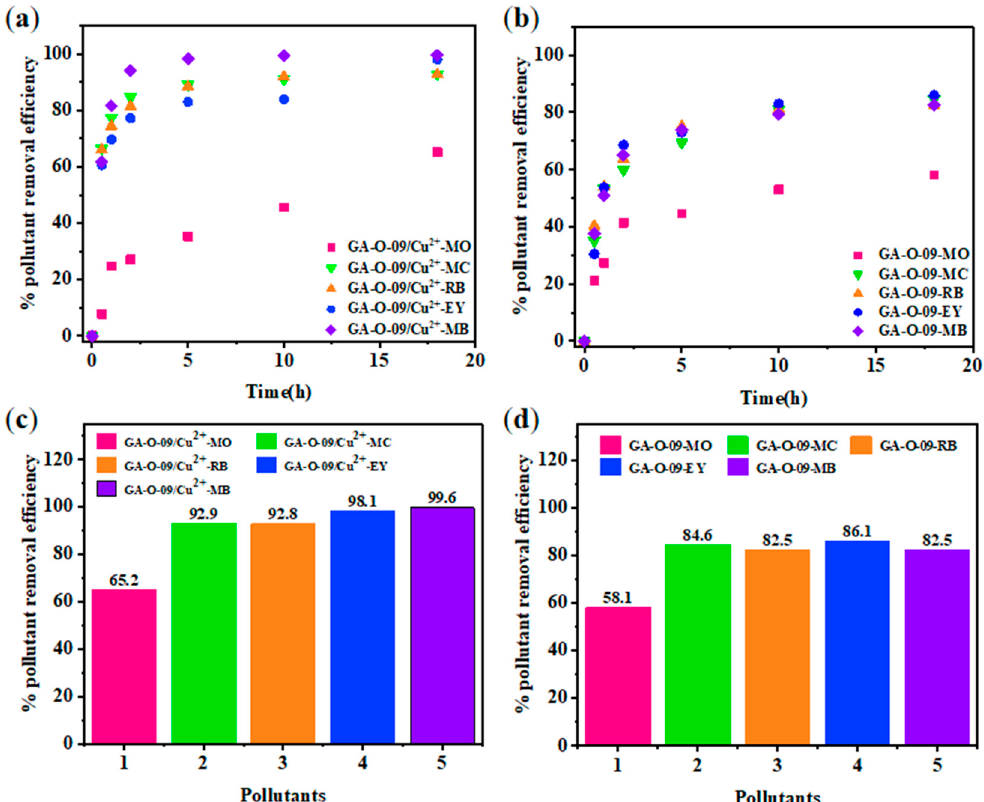
Figure 8. Adsorption process of each pollutant (250 mg/L) at different points in time: ( a ) GA-O-09/Cu 2+ hydrogel; ( b ) GA-O-09 hydrogel; and removal efficiency of each pollutant at the equilibrium state: ( c ) GA-O-09/Cu 2+ hydrogel; ( d ) GA-O-09 2+ hydrogel.